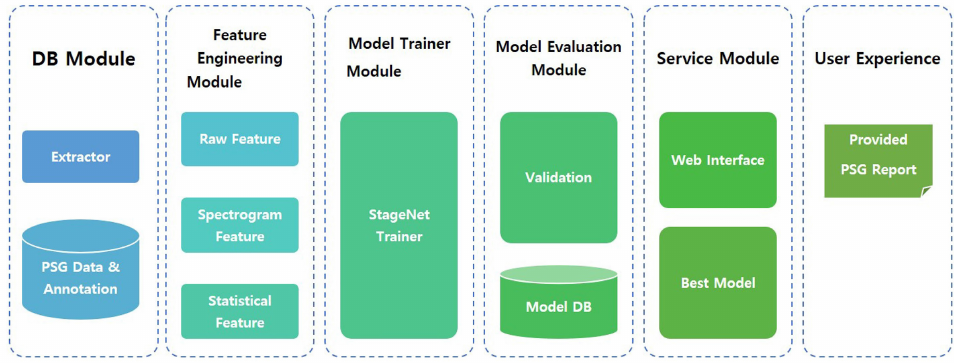
Figure 1. Block diagram of the system architecture. DB: database, PSG: